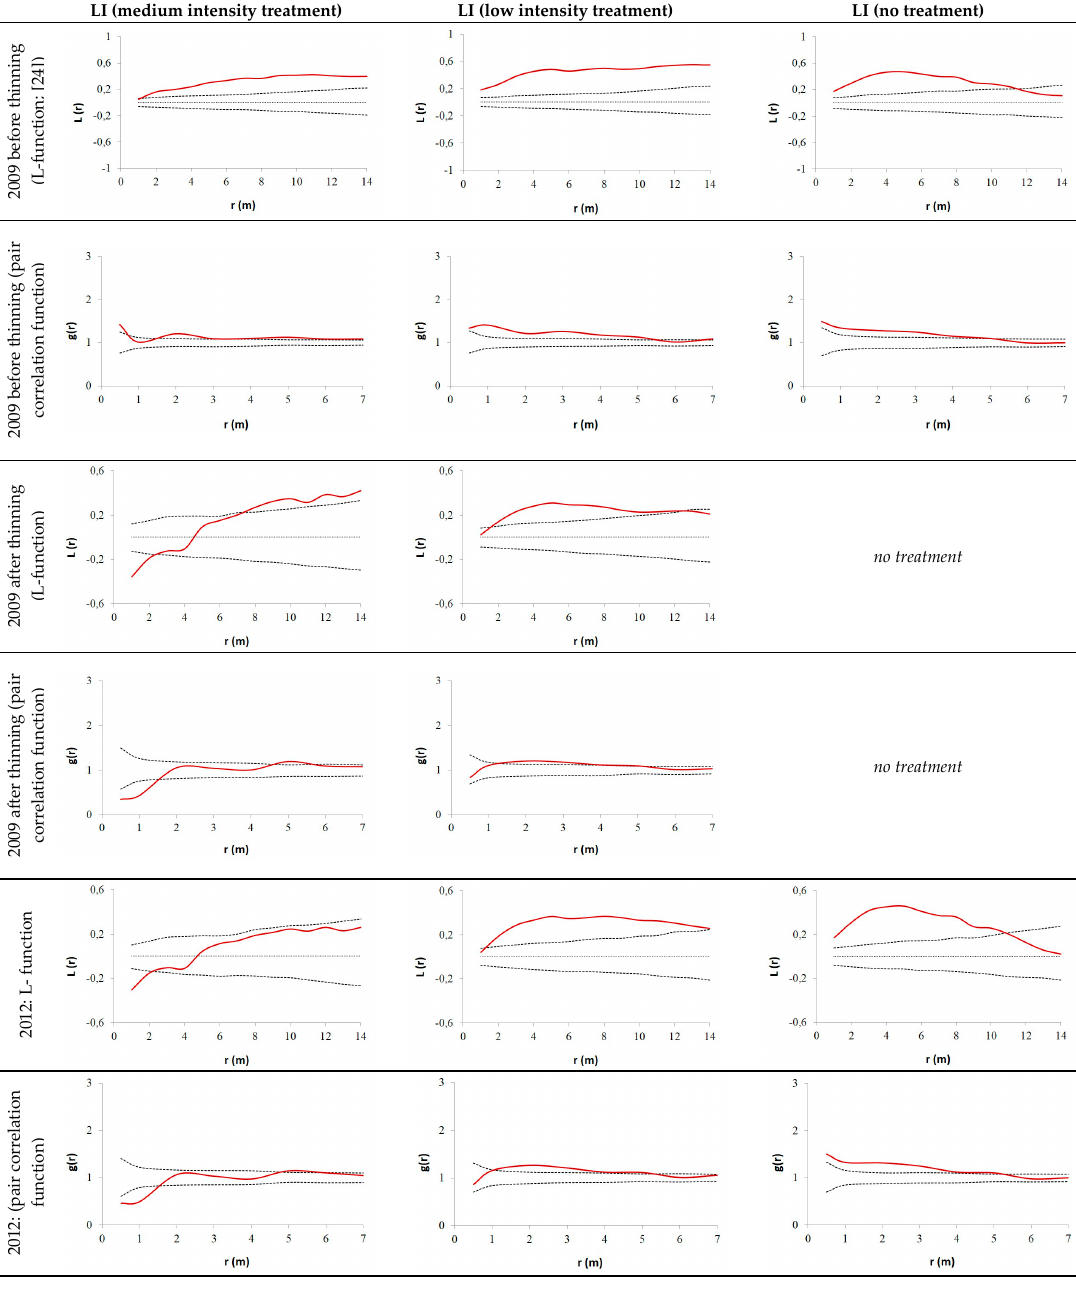
Figure 5. L-function and pair correlation function of the plots in stand LI before and after thinning in 2009 and at the end of the observation period in 2012.